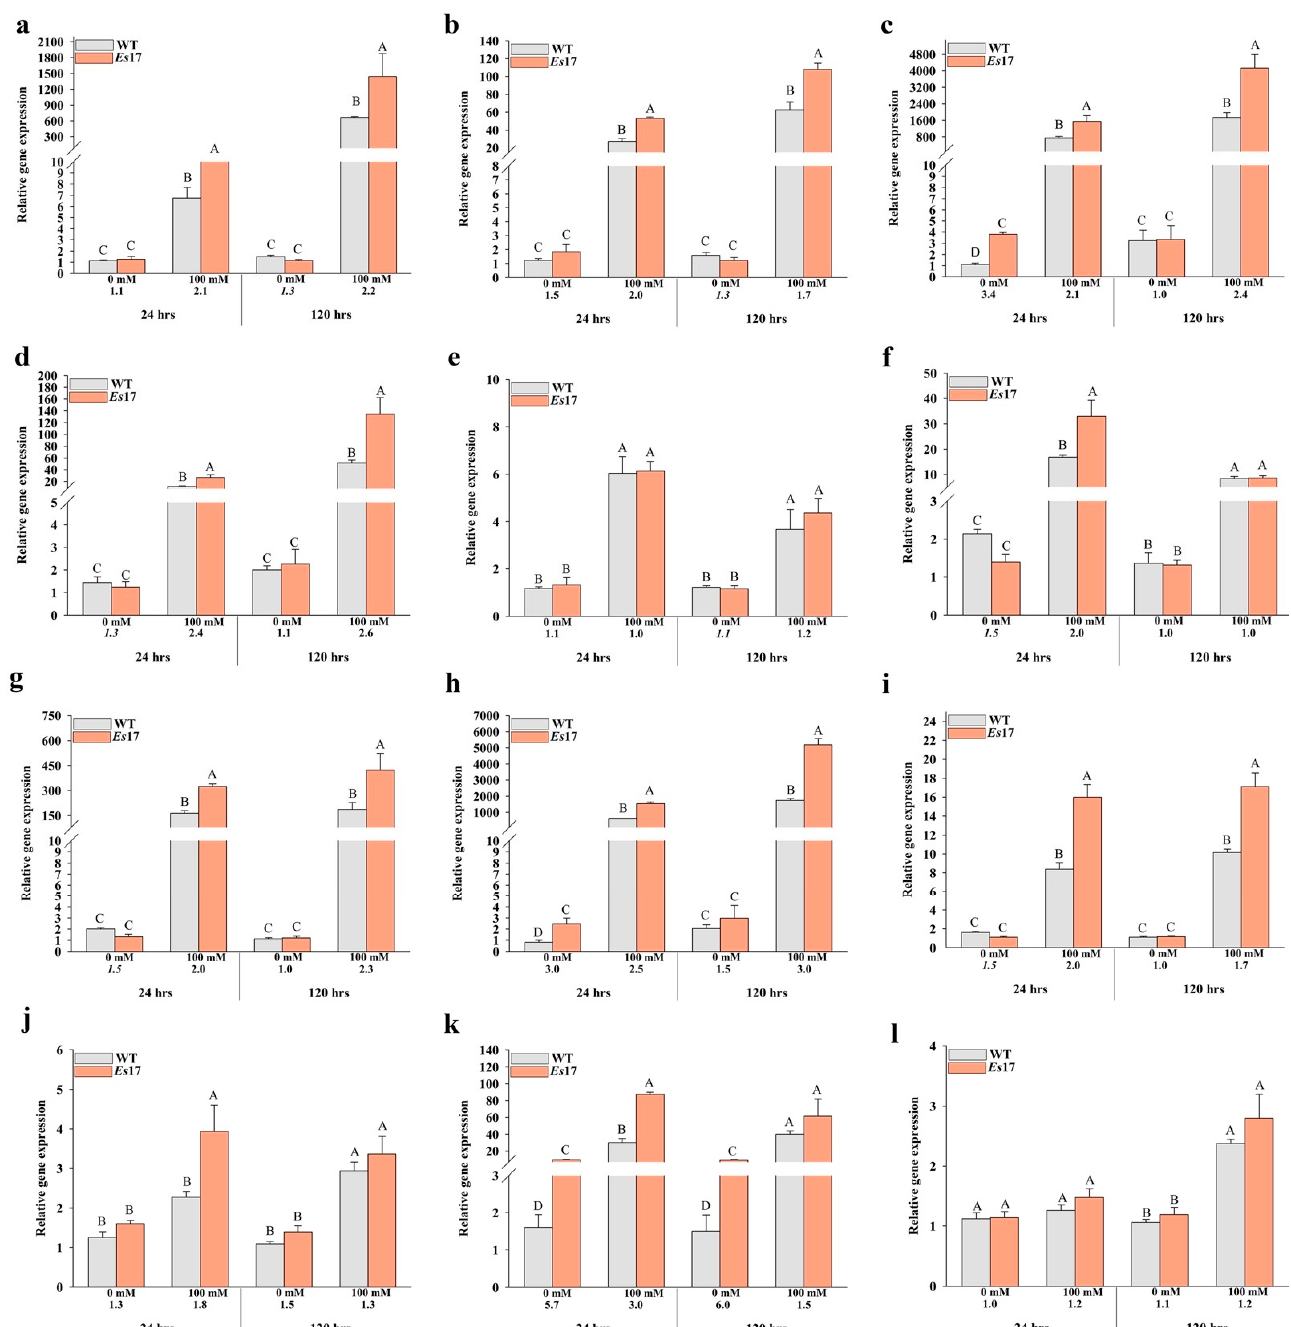
Figure 6. Gene expression analysis of stress inducible marker genes in wild type and transgenic A. thaliana plants ( Es 17Ox-2) grown in absence and presence of 100 mM NaCl. Two time points (24 and 120 h) were studied. Actin was used as the endogenous control, and transcript levels were normalized to the individual with the lowest expression. Values listed under the bars represent fold difference; default font values represent up-regulation while italicized font values represent down-regulation. Data represent mean ± SE from 3 biological replicates. ( a ) DREB2A, ( b ) RD29A, ( c ) RD29B, ( d ) RD26, ( e ) RD22, ( f ) RD20, ( g ) RAB 18, ( h ) LEA, ( i ) LEA14, ( j ) NHX1, ( k ) HSP70 and ( l ) HSFA1D. Means and SE followed by the same letter are not significantly different.